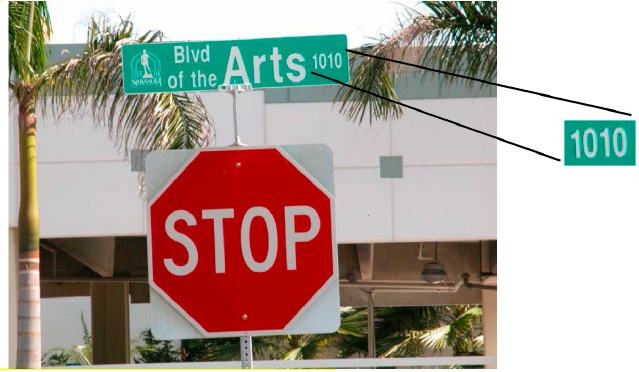
Figure A2. Tampered image (with zoom on tampered detail).